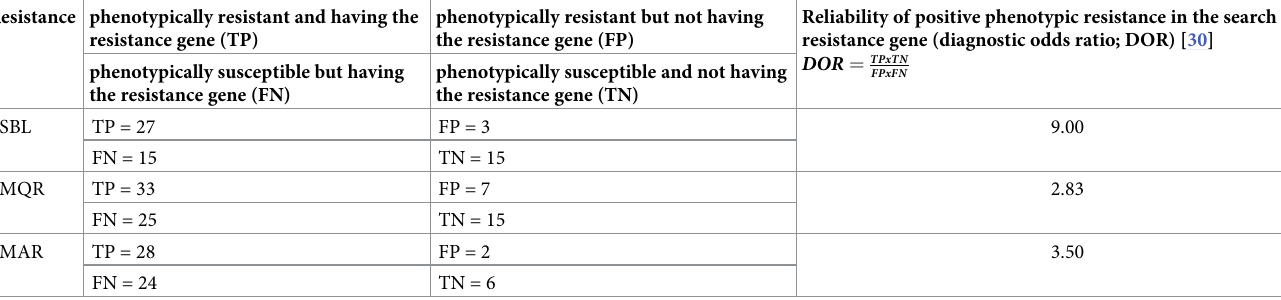
Table 11. Diagnostic odds ratio of a positive phenotypic resistance. Resistance phenotypically resistant and having the resistance gene